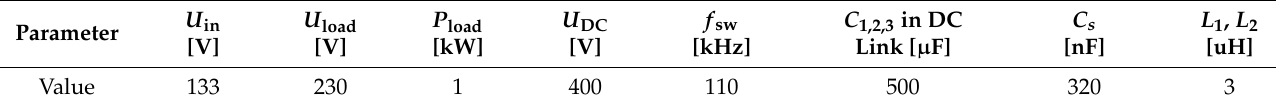
Table 1. Parameters for simulation of the proposed SC-AC